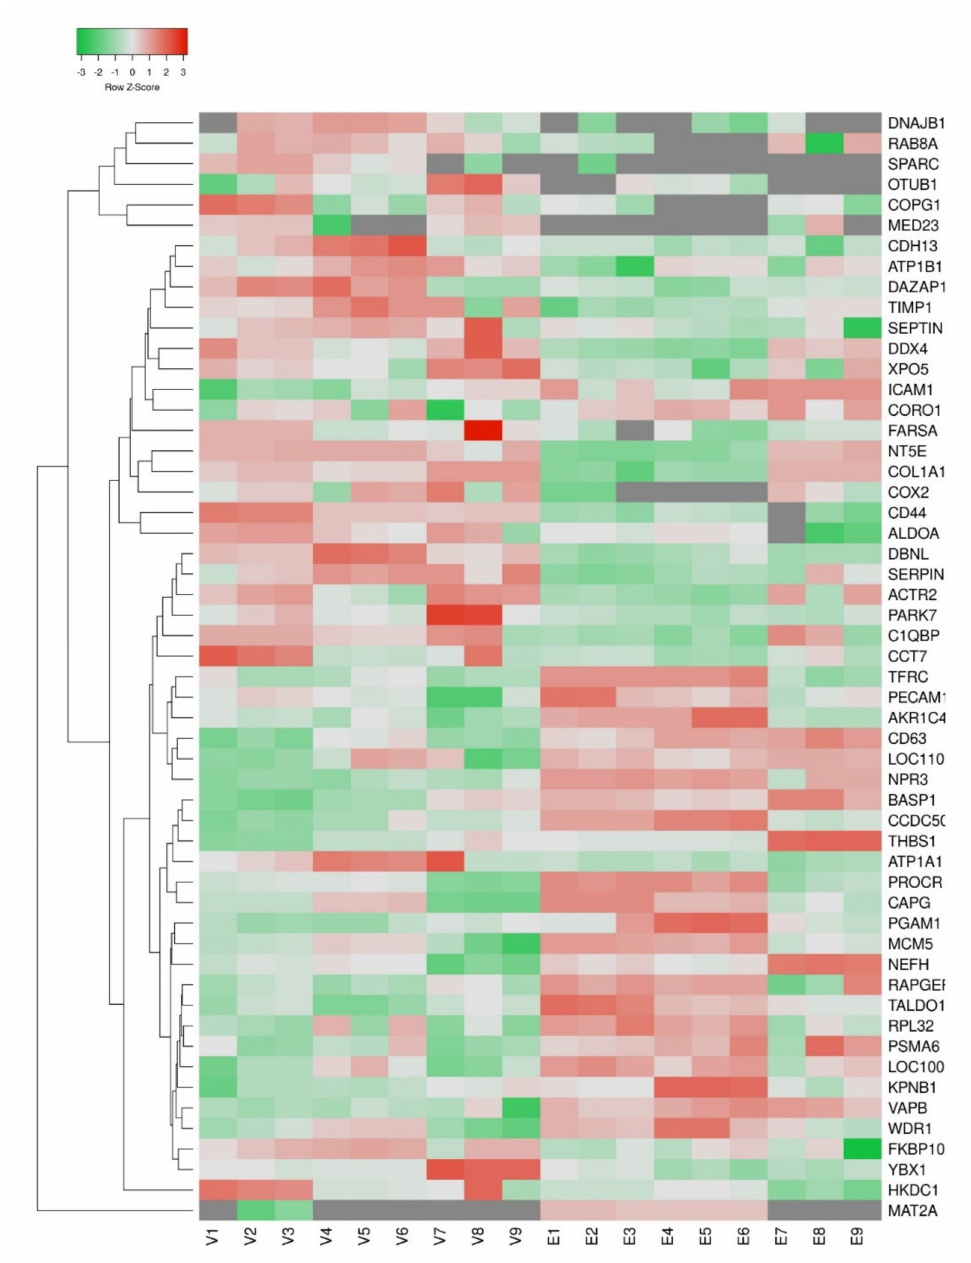
Figure 2. Heatmap represents differentially changed proteins in aortic valvular and endocardial endothelium. The normalized peptide intensities from label-free proteomics data were used to create the Heatmap using the Heatmapper tool. Supplementary Table S1. Fold change > 1.5 was considered significant. V—Aortic Valvular endothelial cells; E—Endocardial endothelial